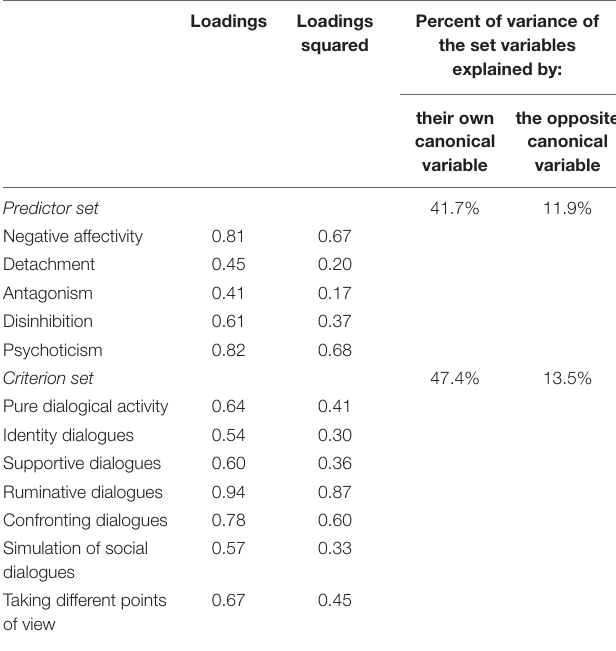
TABLE 5 | Results for the first canonical